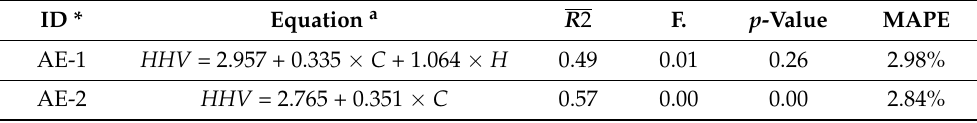
Table 8. Summary of the HHV equations, AE-1 and AE-2, obtained from ultimate analysis.